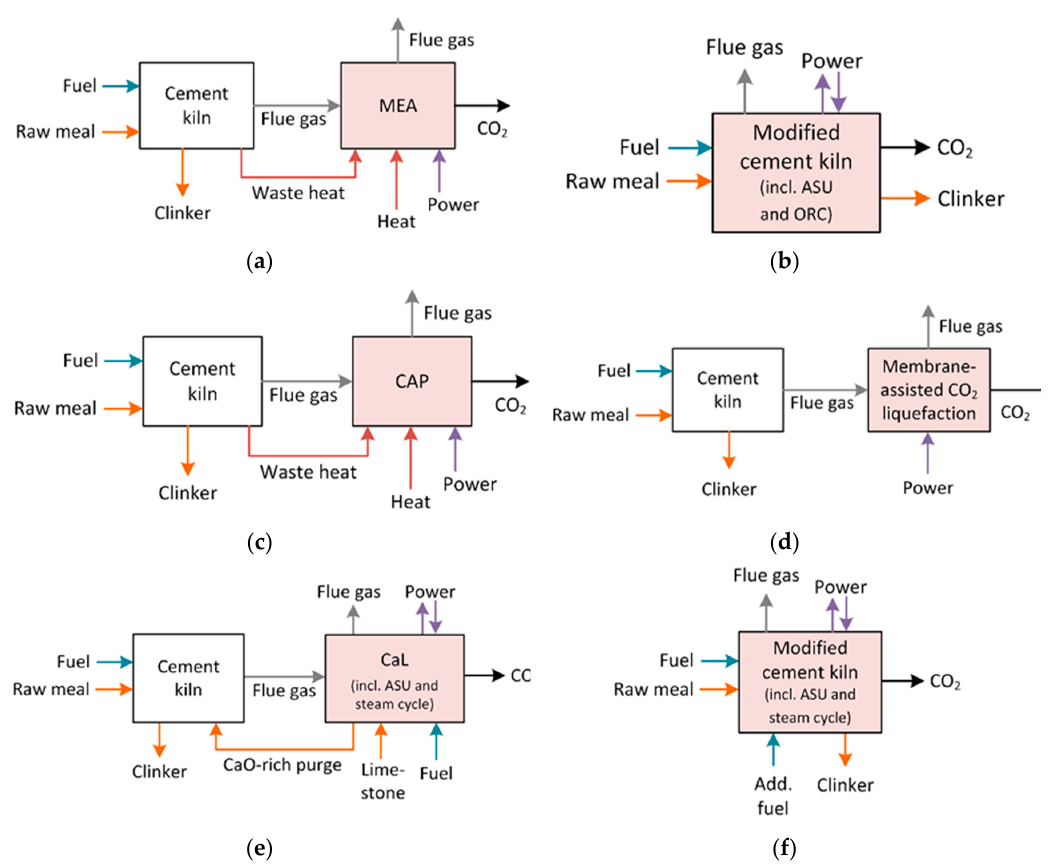
Figure 2. Schematic overview over investigated technologies (pink) and their integration into the reference kiln (white). ( a ) Reference technology: MEA; ( b ) Oxyfuel; ( c ) Chilled ammonia process; ( d ) Membrane-assisted CO 2 liquefaction; ( e ) Calcium looping-tail-end; ( f ) Calcium looping integrated.